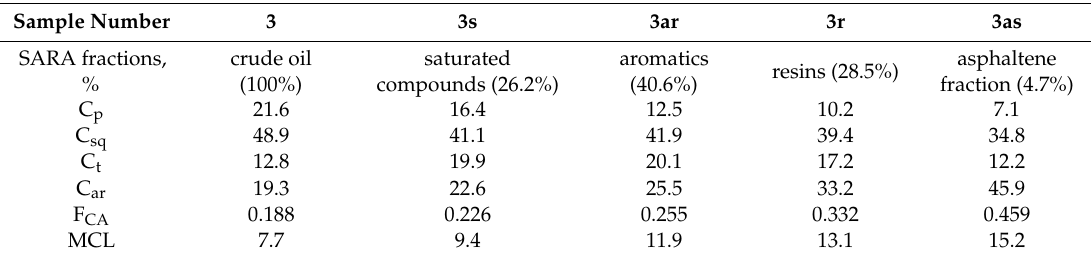
Figure 4. 13 C (175 MHz) NMR spectra of oil samples 3s–3as (s—saturated compounds, ar—aromatics, r—resins, as—asphaltene fraction). Table 7. Molar fractions (%) of primary (C p ), secondary and quaternary (C sq ), tertiary (C t ), aromatic (C ar ) groups, aromaticity factor (F CA ), and mean chain length (MCL) of aliphatic hydrocarbons based on 13 C NMR spectra of samples 3, 3s–3as.